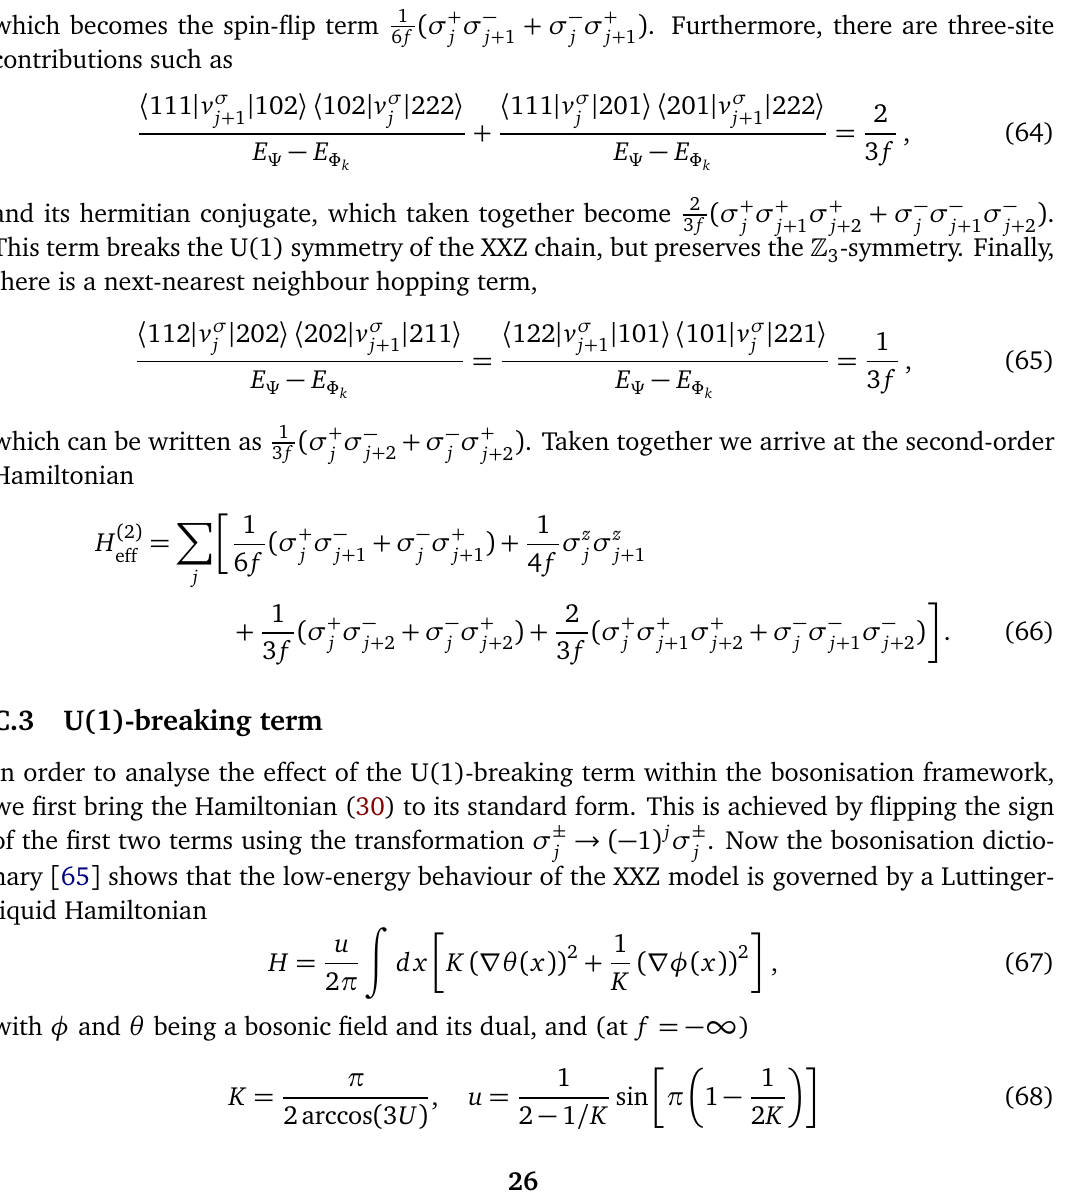
Figure 15: Finite-size scaling of the gap δ L = 64,65,...,100 for the system in the critical XXZ phase ( U = − 0.25, f = − 3). The gap is depicted with a small δ , to signal that it is zero in the thermodynamic